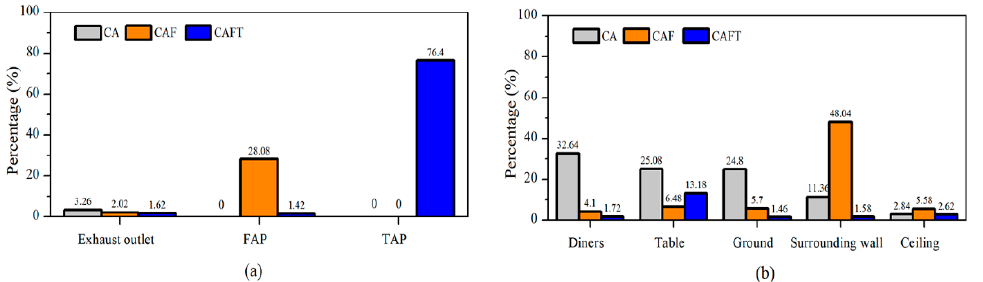
Figure 9. Particle distribution statistics for CA, CAF, and CAFT, respectively: ( a ) percentage of particles discharged from the exhaust outlets and purified by the purifiers; ( b ) percentage of particles deposited on different surfaces.